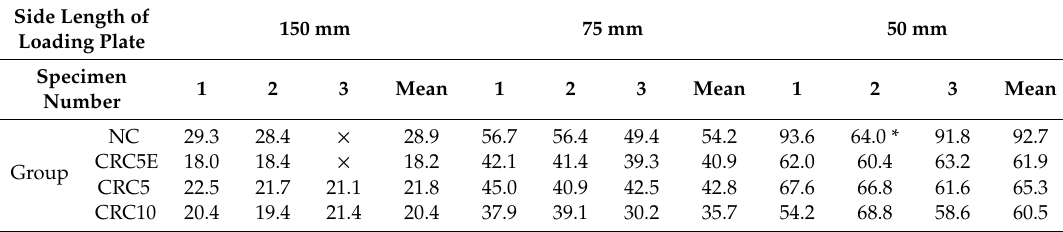
Table 2. Compressive strength and bearing strength of concrete